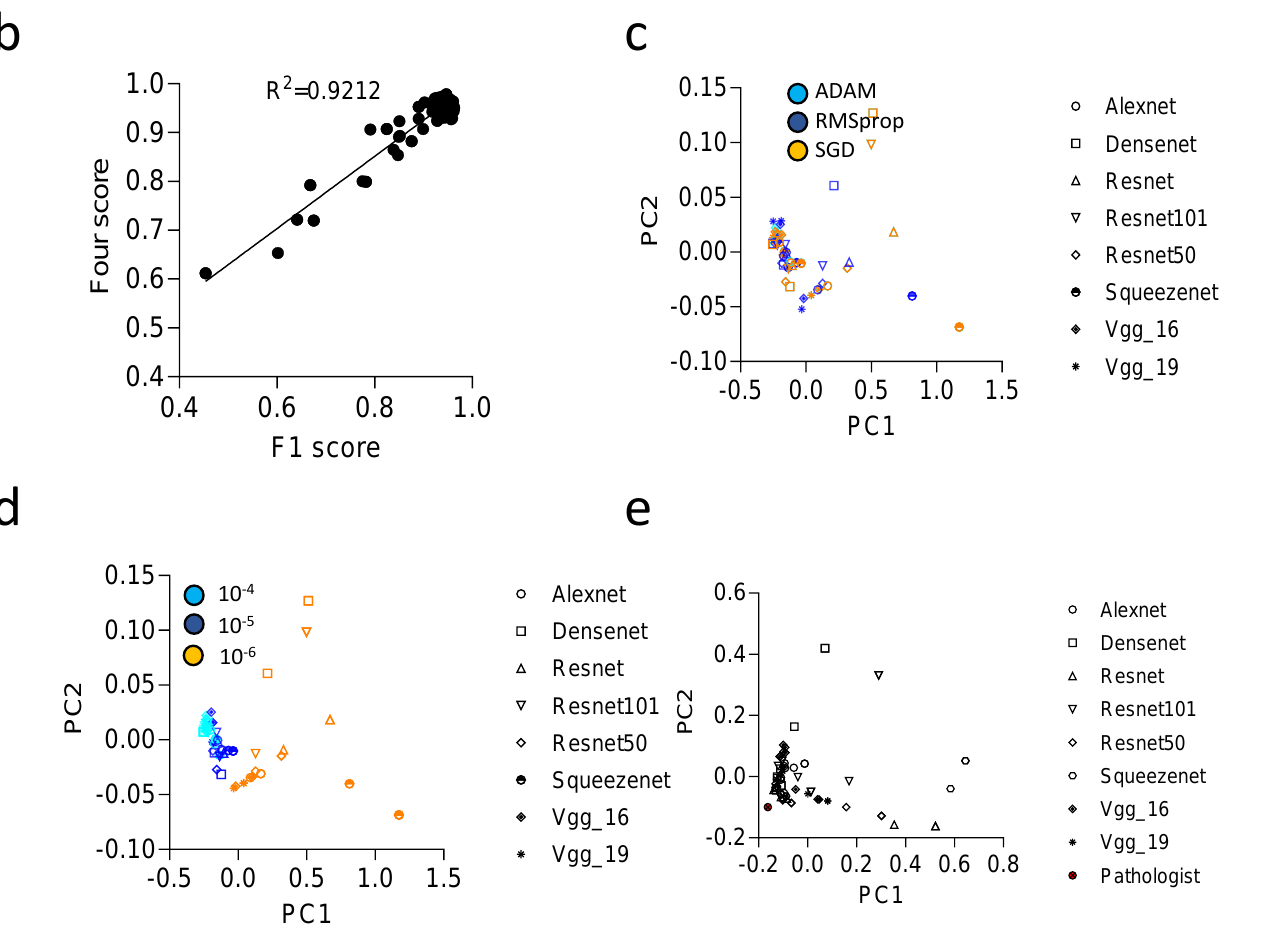
Figure 6. Hyperparameter Tuning illustrates the performance of different network architectures trained with variable learning rates and optimizers. ( a ) Performance of 72 trained and validated neuronal networks were ranked regarding the four-score, highlighting the best 10 network configura- tions. ( b ) Correlations were tested between F1-score and four-score via r2-score. ( c , d ) PCA (linear kernel) of the network metrics from hyperparameter tuning colored by the ( c ) different optimizers and architectures, ( d ) learning rates and architectures, and ( e ) PCA (linear kernel) of the modified four-score parts: HLN-score, HP-score, PDAC-score and LNMP-score (vs. the pathologist annotations over all 29 validation